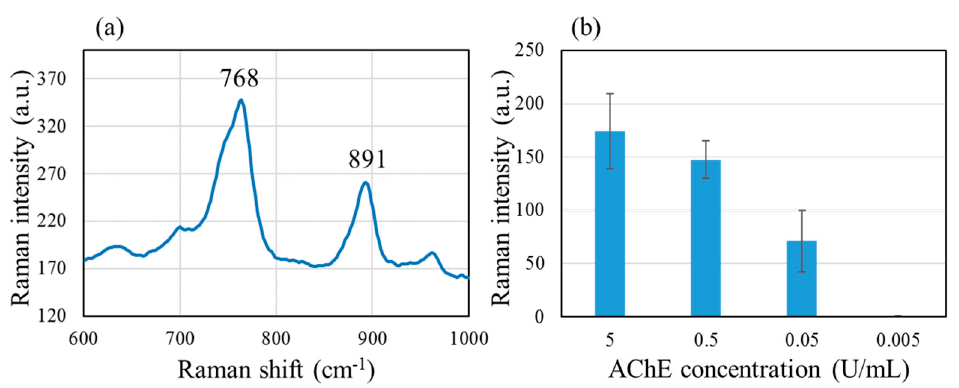
Figure 4. ( a ) SERS spectrum showing characteristic thiocholine (TC) peaks at 768 and 891 cm − 1 , obtained with the standard non-patterned SERS substrate. These peaks correspond to CH 3 rocking and C-S stretching vibrations. ( b ) A bar graph showing the intensity of the 768 cm − 1 peak monitored for various AChE concentrations, using 10 − 4 M ATC.